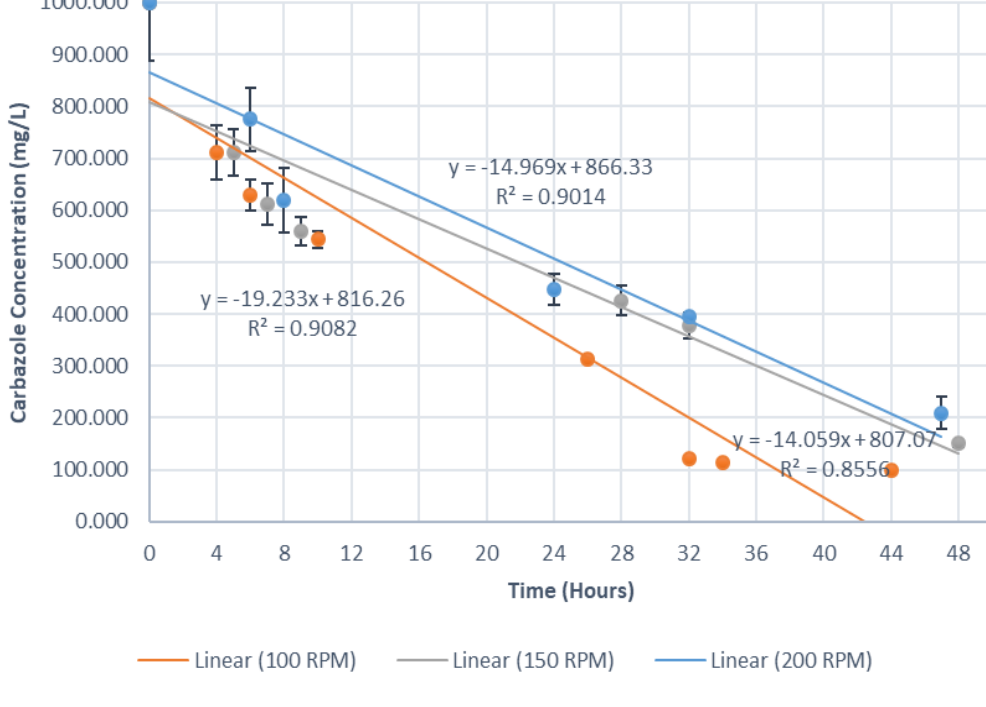
Figure 3. Biodegradation rate trend at 100, 150 and 200 rpm agitation speed in bioreactor scale Table 3. Kinetic study of immobilized cell with various agitation